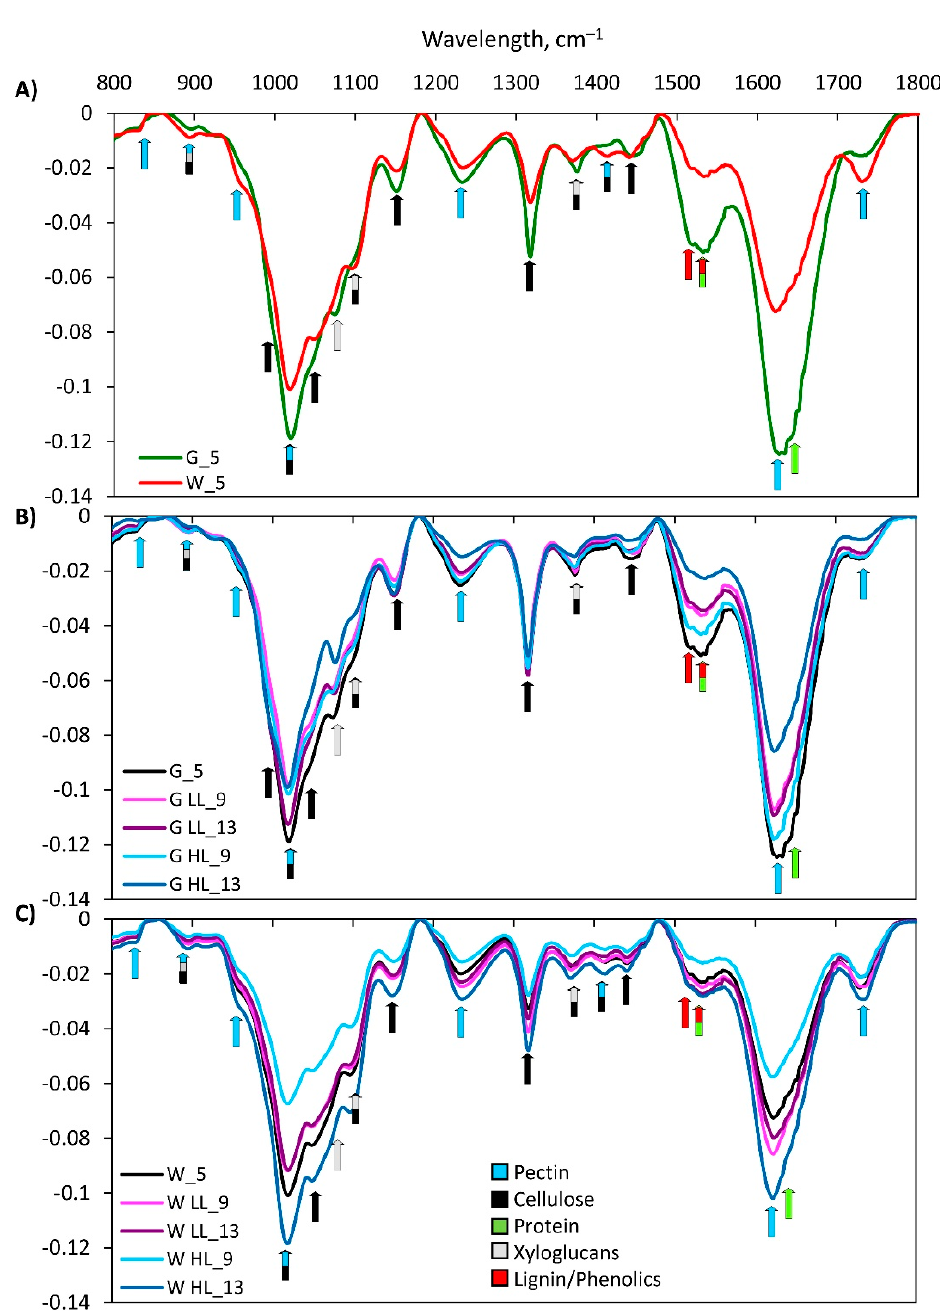
Figure 9. FTIR spectra of cell walls of ( A ) GL (green line) and WL (red line) P. zonale grown under LL; ( B ) GL and ( C ) WL at the beginning (5 d) and after four (9 d) and eight days (13 d) of exposure under HL and lower temperature (18 °C, Cold + HL ). For each spectrum, the average spectra of at least three GL and WL samples (biological replicates) are shown. The peaks of cellulose, pectin, xyloglucan, proteins, and lignin (phenolic ring and phenolic esters) are highlighted. Cellulose: 898, 1005, 1020, 1052, 1097, 1147, 1320, 1376, 1416, 1443 cm –1 ; pectin: 822, 899, 955, 1017, 1236, 1420, 1630, 1733 cm –1 ; xyloglucan: 898, 1072, 1097, 1147, 1368 cm –1 ; lignin: 1517, 1534 cm –1 .